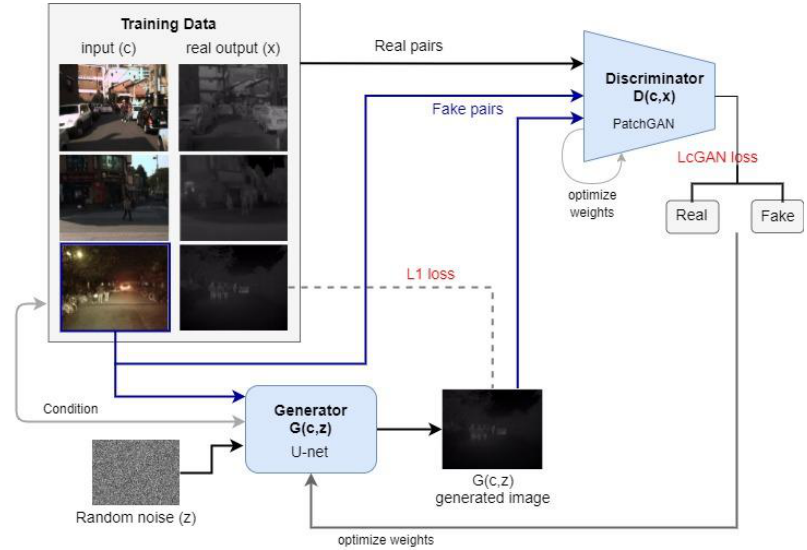
Figure 7. Pix2Pix for nighttime image